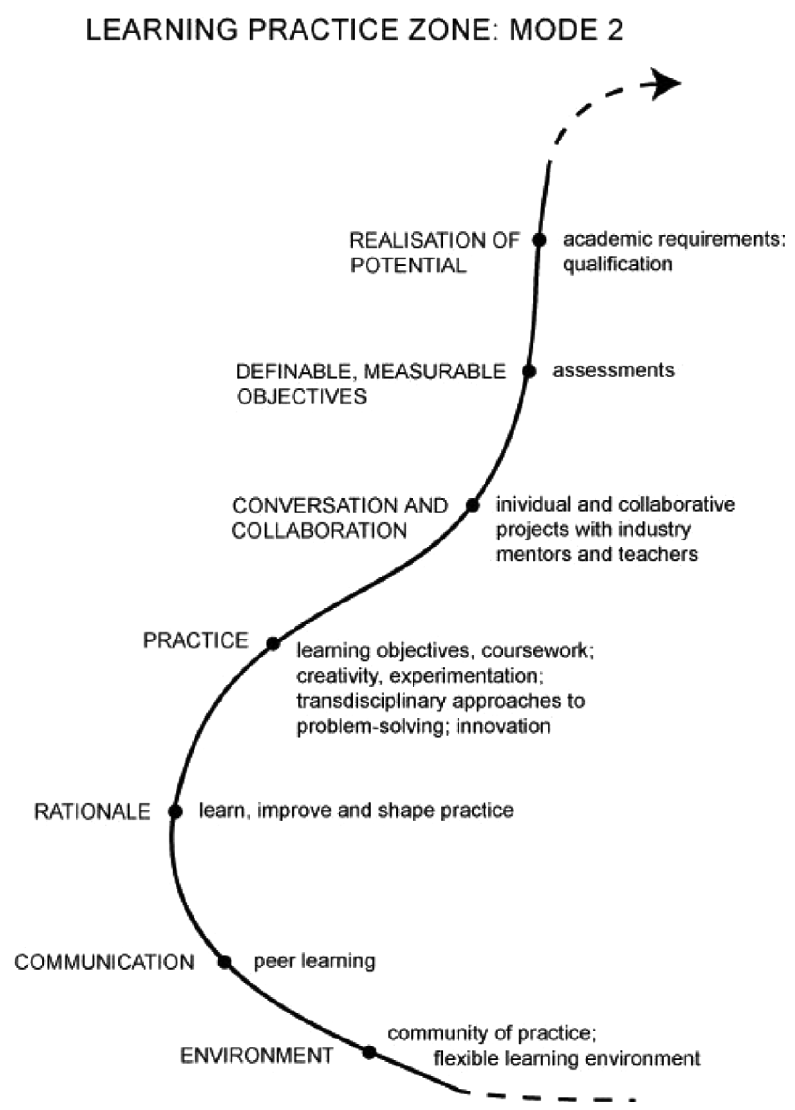
Figure 2. Action pathway of seven steps in the learning zone to develop Mode 2